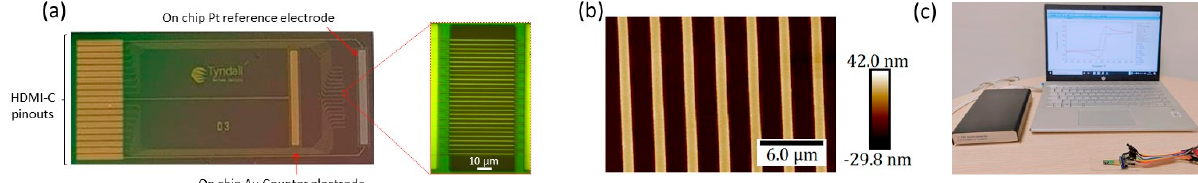
Figure 1. ( a ) optical micrograph of the HDMI-C sensor chip, showing the Au counter electrode, the 8 Pt working electrodes and the Pt reference electrode; with higher magnification of one of the working electrodes; ( b ) Atomic Force microscope image of the working electrode. The interdigitated microbands are 1 µ m wide with 2 µ m gaps; ( c ) Experimental setup comprising sensor chip, connector, portable bipotentiostat and laptop.